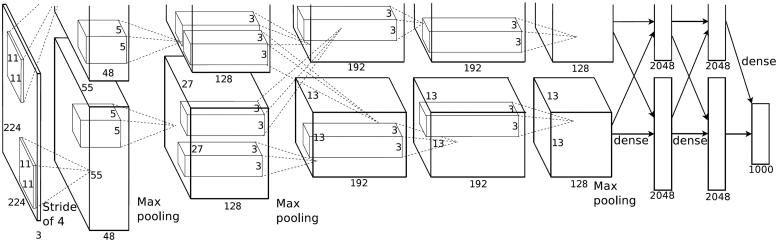
AlexNet architecture [15]. (With permission)